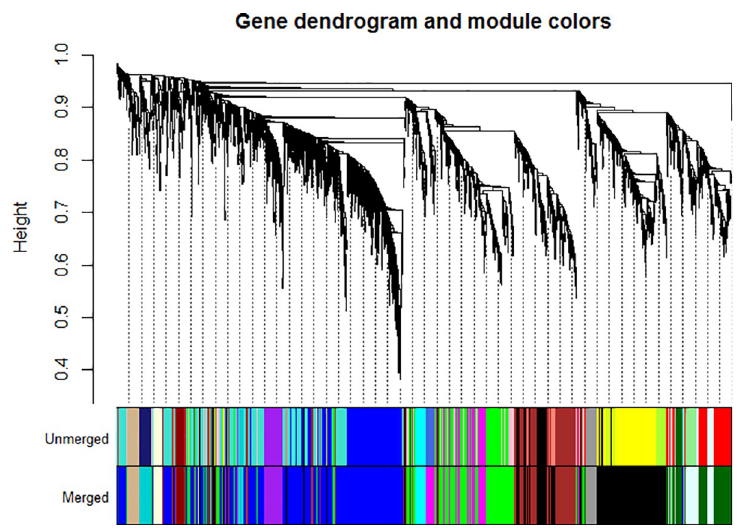
Fig 2. Gene dendrogram and module color. Cluster dendrogram is based on the topological overlap of gene expression across diverse conditions. The coloured panel beneath the dendrogram shows modules obtained from WGCNA study. The upper panel indicates unmerged modules, whereas the lower panel shows modules after merging based on ME values. Each module possesses at least 20 genes.